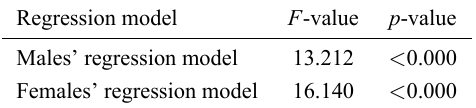
Fig. 1. Oxygen uptake and heart rates comparison of GXT and 10-m MST in males. GXT means gradually maximal exer- cise test and MST means multistage shuttle-run test. The X-axis is exercise duration time by the minute, and the Y-axis of (A) is oxygen consumption during exercise, and the Y-axis of (B) is heart rate per minute during exercise. Table 5. Results of F -test for each regression model.